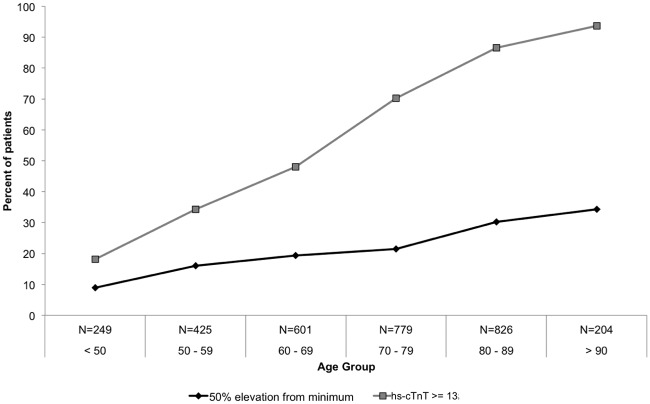
High sensitivity troponin levels and dynamics by age group.The percent of admissions having maximal high sensitivity troponin levels > 99th percentile as well as those with hs-cTnT change of 50% or more correlate with patient age (p for trend < 0.0001 for both).